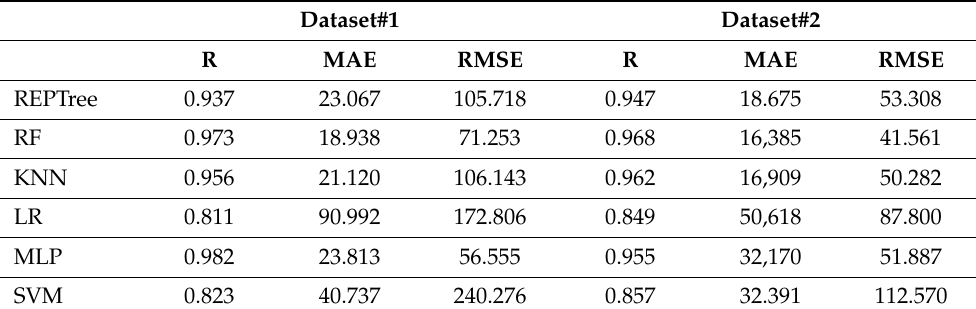
Table 1. Regression analysis results of LCOM2